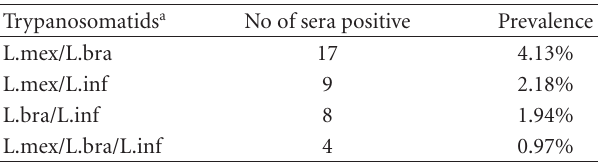
Table 5: Detection of co-infection in 412 sera of dogs of the Yucatan Peninsula (Mexico) by ELISA.